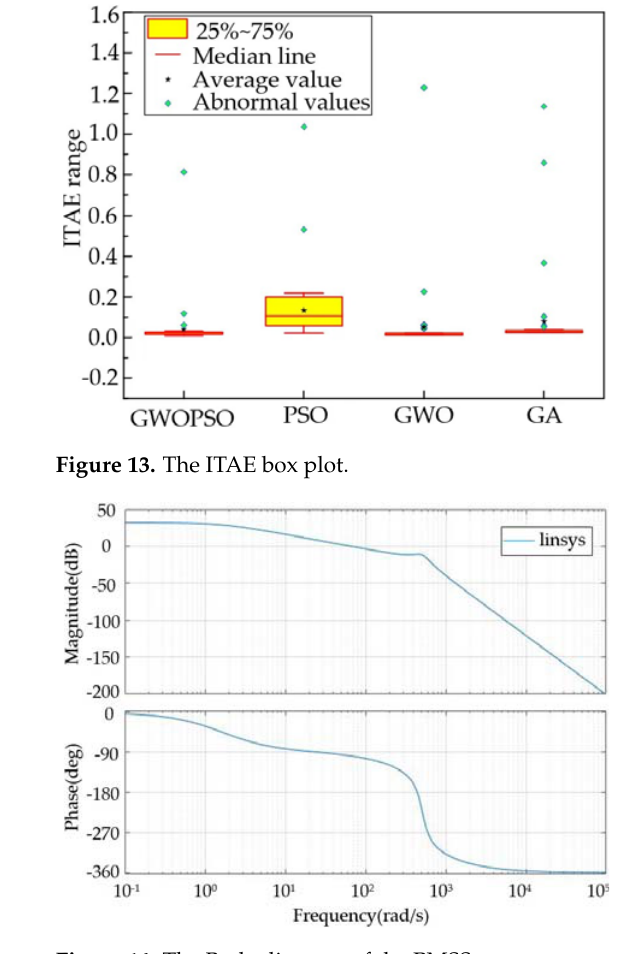
Figure 14. The Bode diagram of the PMSS.